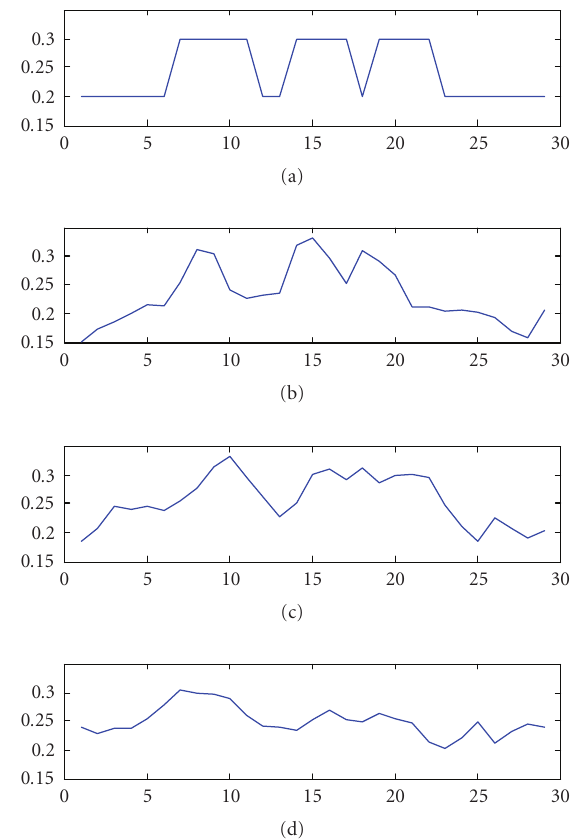
Figure 10: Comparison of system profiles for (a) original phantom, (b) system A, (c) system C, and (d) system